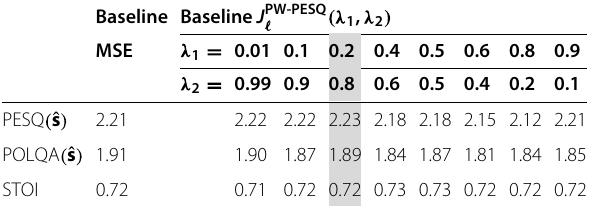
Table 5 Optimization of hyperparameters 1 and 2 for baseline PW-PESQ (5) on 12 . 5 % of the validation set . The selected setting is